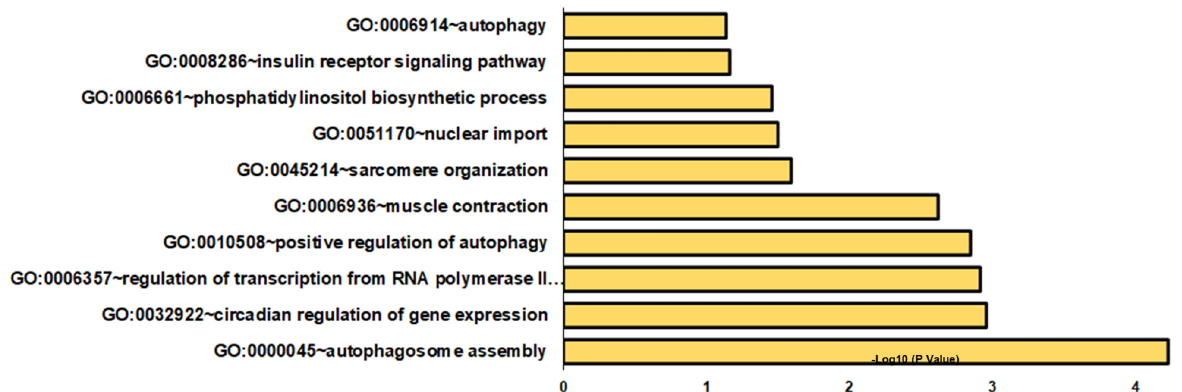
Figure 4. Gene enrichment analysis of biological processes in DOC and eplerenone plus DOC DETs. The graph indicates the − log 10 ( p -values) of enriched BPs of differentially expressed transcripts from the DOC vs. eplerenone plus DOC groups with p -values < 0.05.